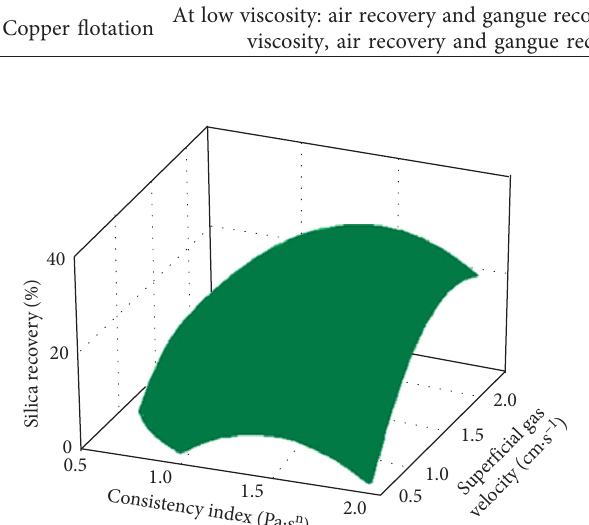
Figure 12: Surface plot of hydrophilic quartz recovery versus consistency index and superficial gas velocity (after